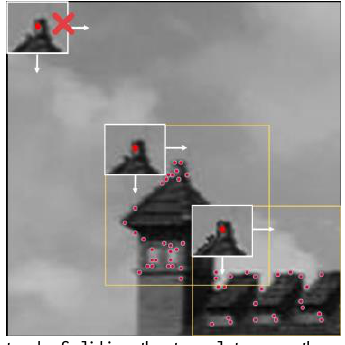
Figure 6. Instead of sliding the template over the whole ROI, it is more efficient to create smaller sub-windows around the possible detected features in the ROI.